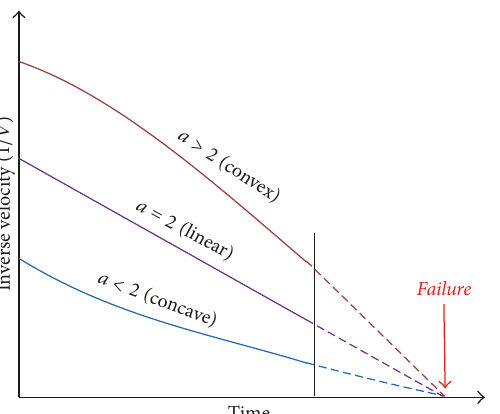
Figure 8: Inverse velocity trend lines to predict the time of failure [27].